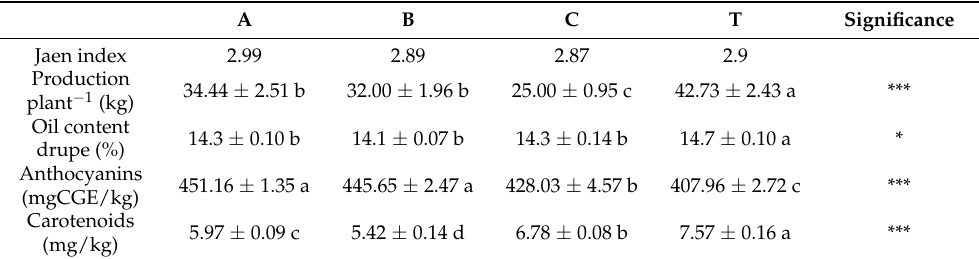
Values are mean ± standard error. Different letters indicate significant differences according to Duncan’s multiple- range test ( p = 0.05). Asterisks indicate significant effect of biostimulants treatments according to